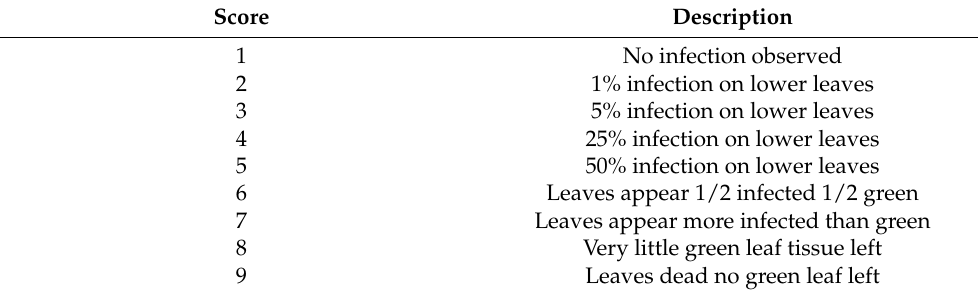
Table 2. Scoring scale for